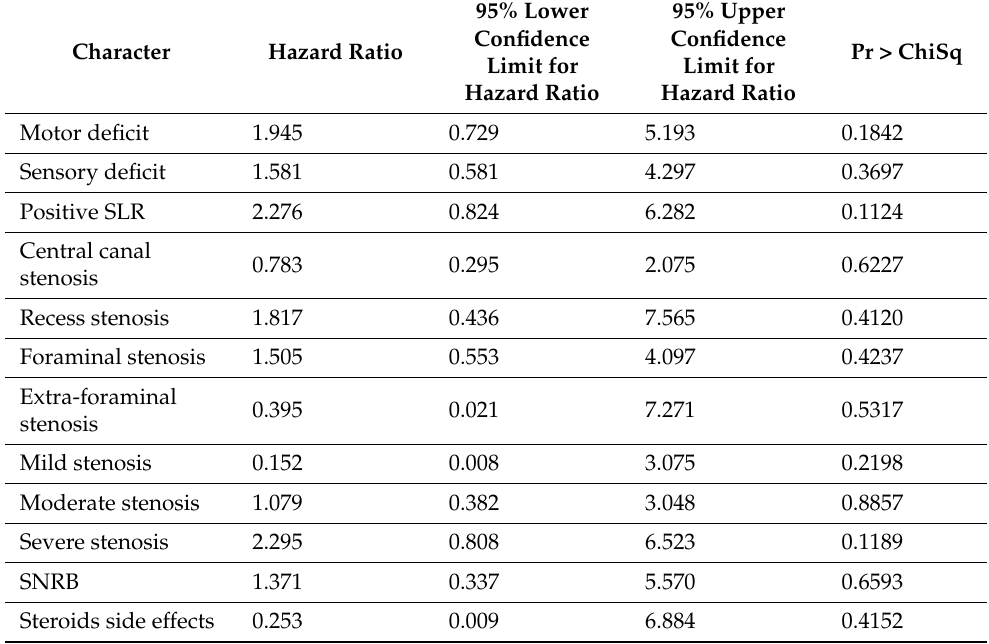
Table 2. Hazard Ratios